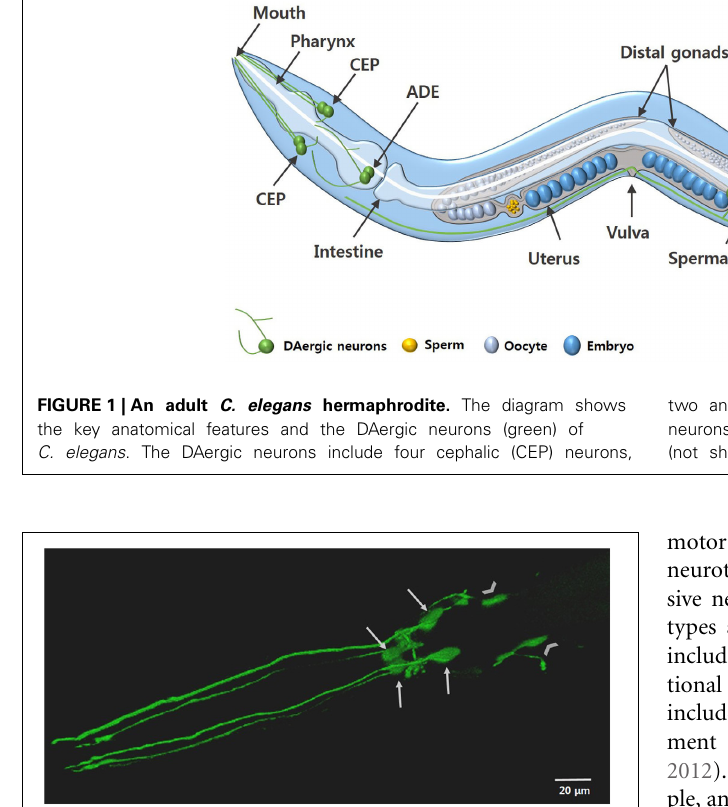
FIGURE 2 | The anterior DAergic neurons of an adult C. elegans hermaphrodite. The neurons are visualized by the translational expression of GFP driven by the promoter of the DA transporter (P dat − 1 ::GFP). The key features highlighted include the cell bodies and dendritic processes of the four CEP neurons (arrows) and the cell bodies of the two ADE